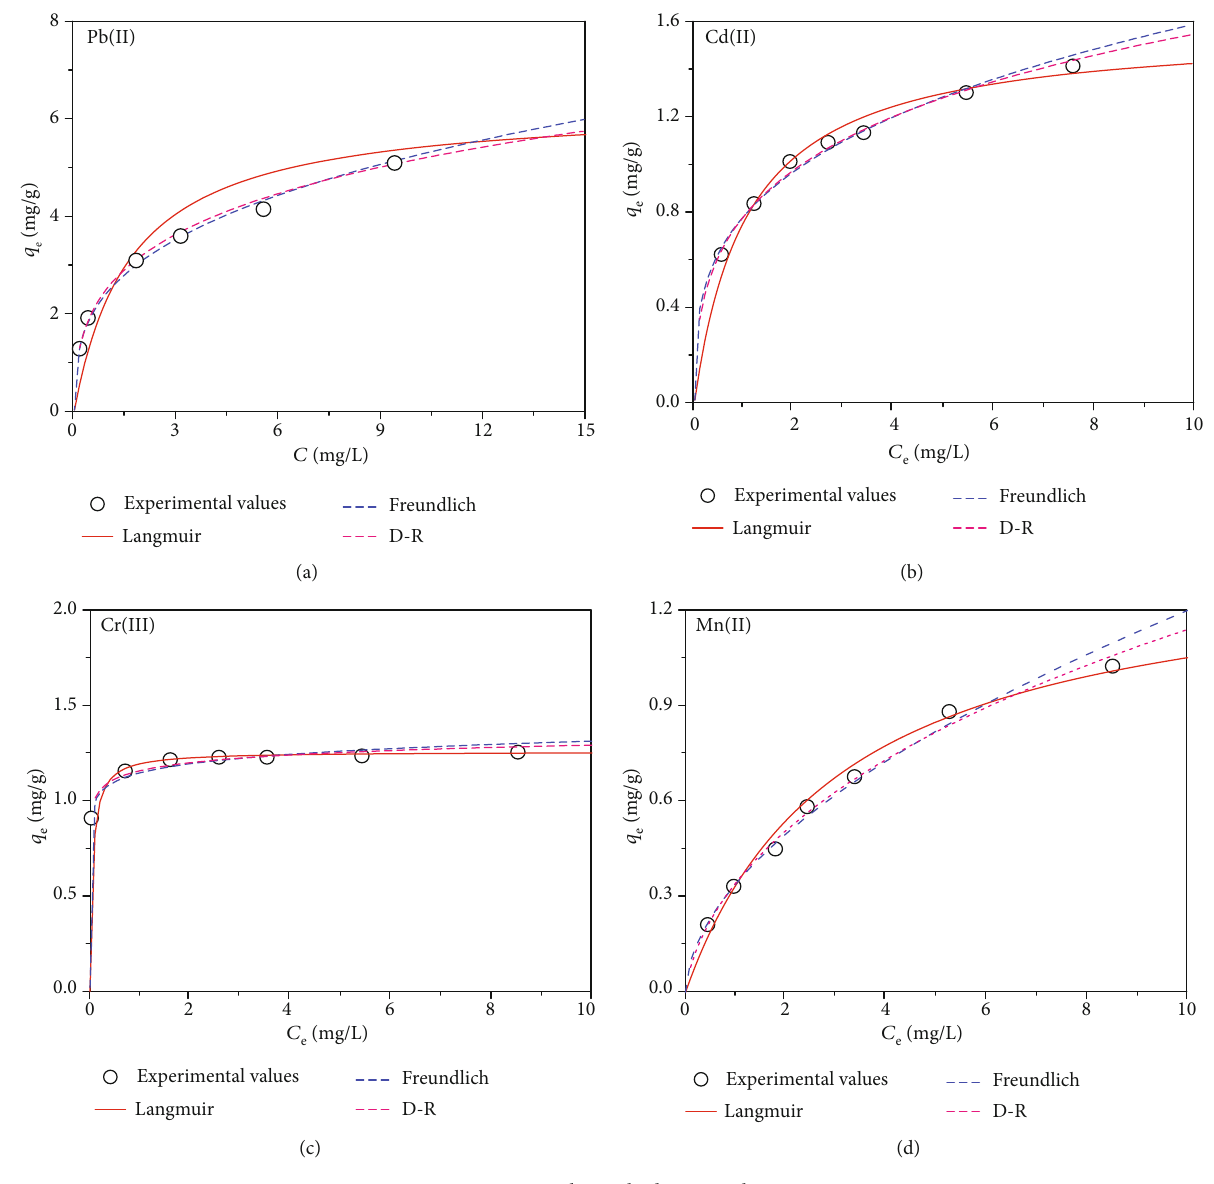
Figure 7: Isothermal adsorption line.